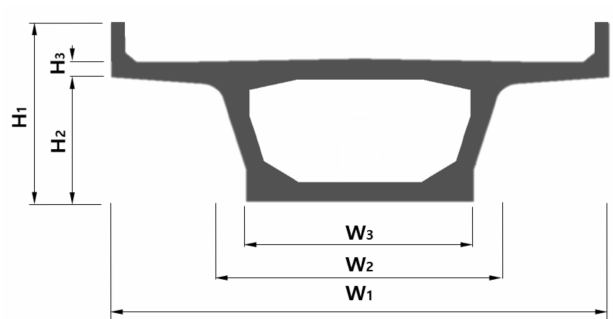
Figure 14. Design parameters for a prestressed concrete (PSC) box girder bridge.